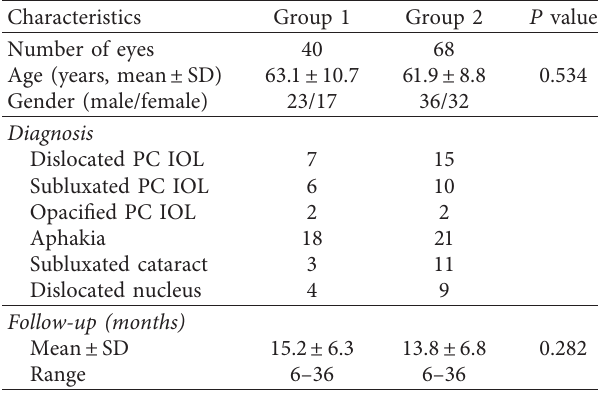
Table 1: Patient